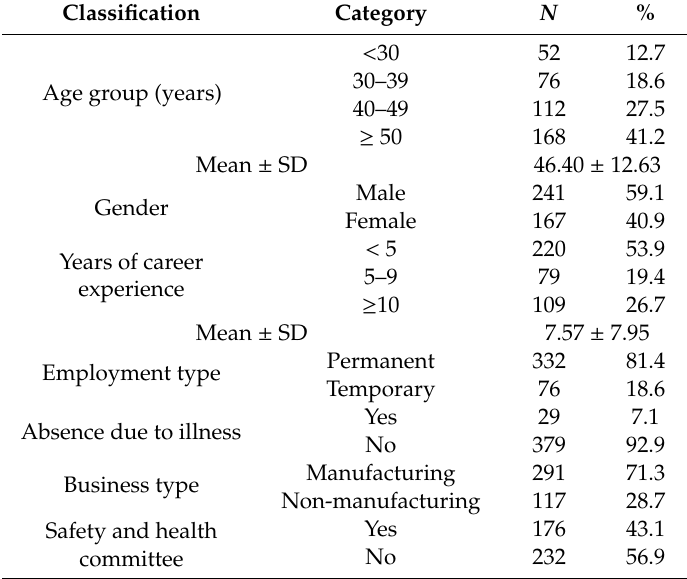
Table 1. Demographic characteristics of study participants ( n =